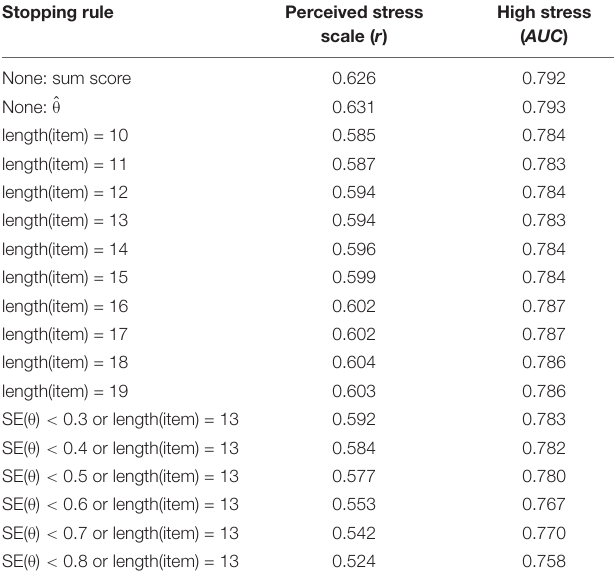
TABLE 4 | Relationship with external criteria of the stress CAT (CAT-S) estimates under different stopping rules. Stopping